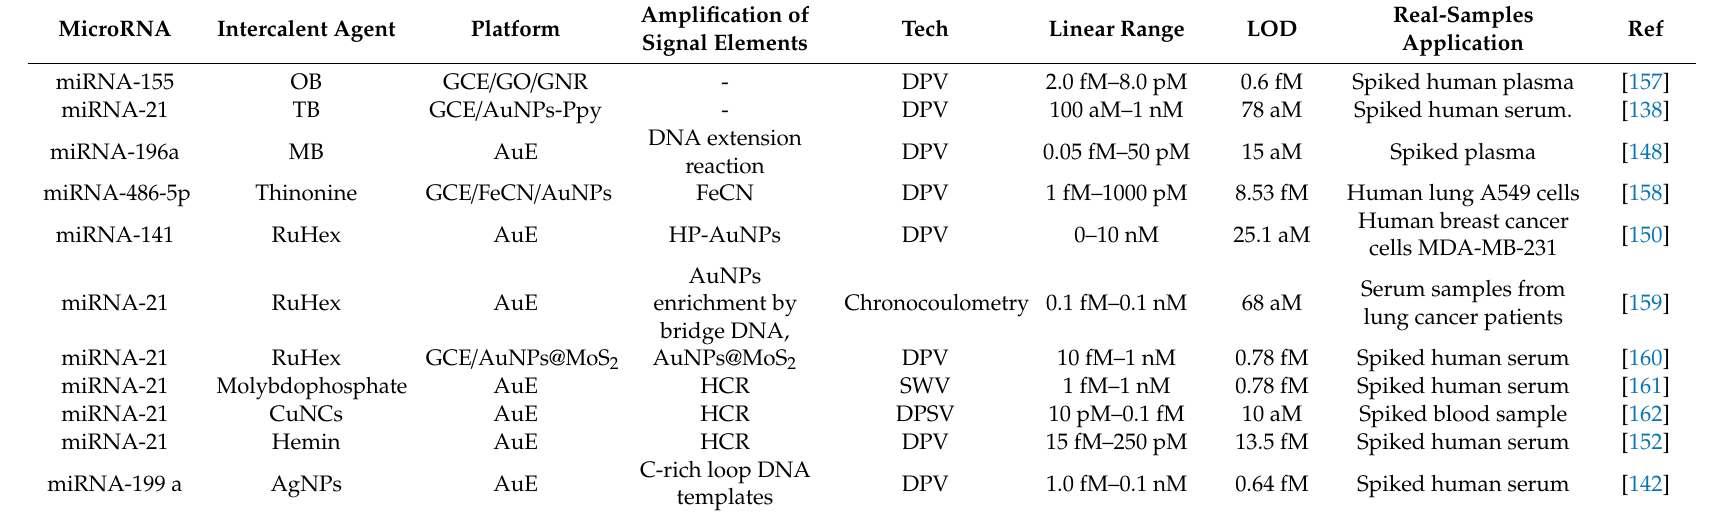
Table 4. Current sensitive electrochemical biosensors using the RedOx intercalating